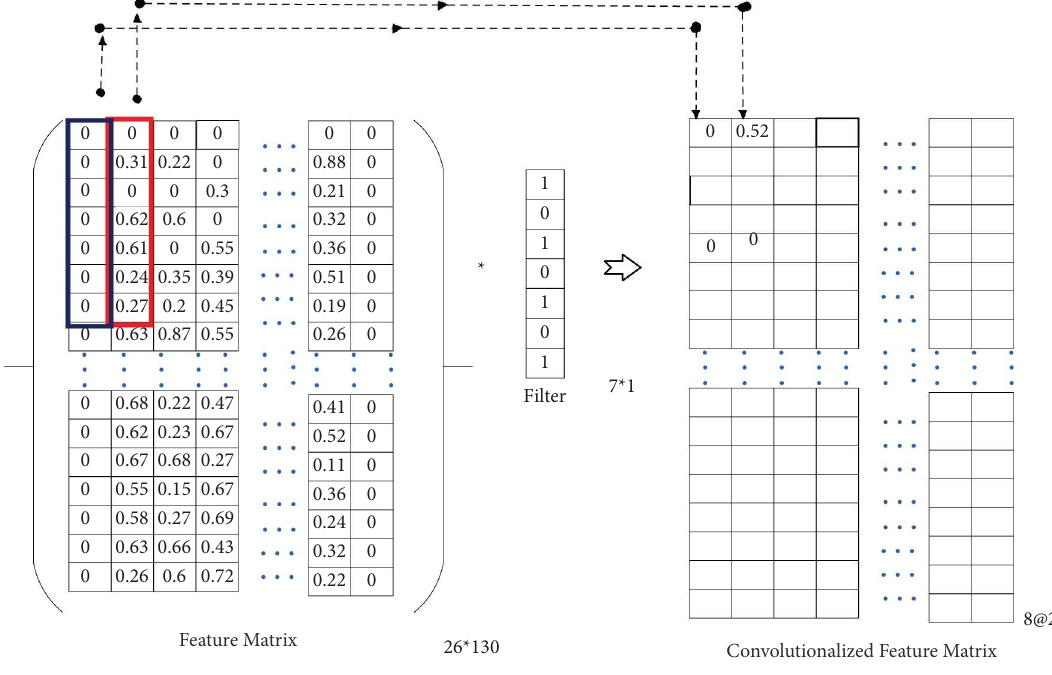
Figure 7: Convolution process.